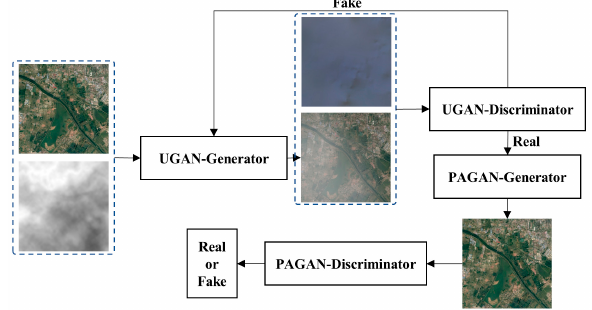
Figure 1. Proposed framework and training process.